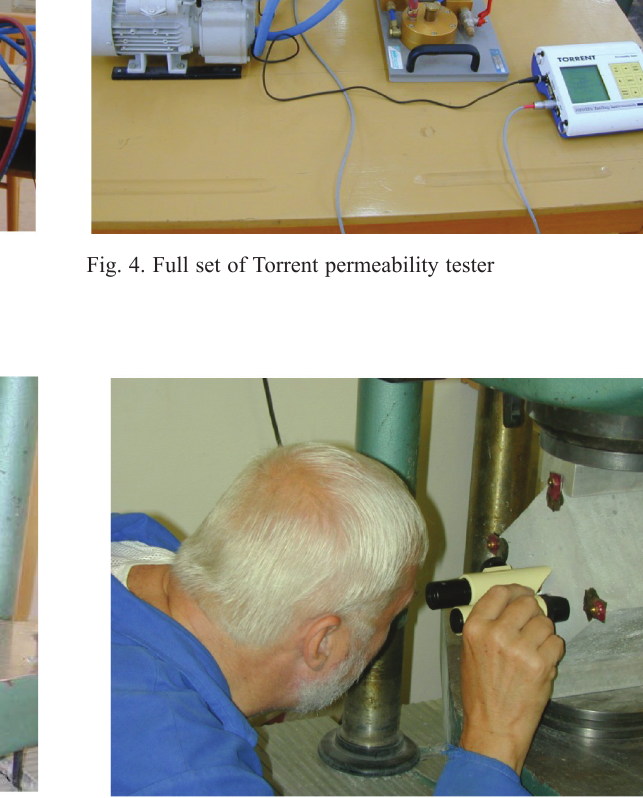
Fig. 6. Microcracks detection with optical